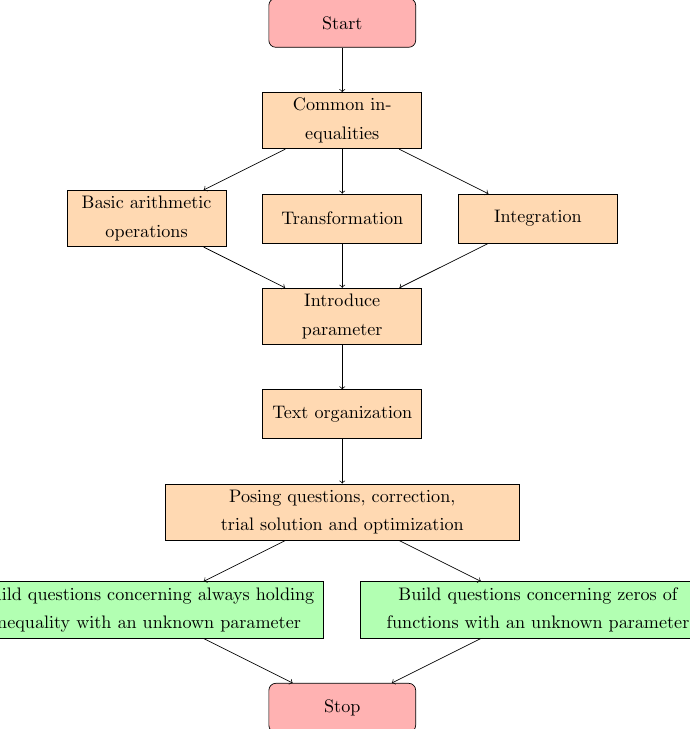
Figure 2. The design framework of math exam questions of always holding inequalities and zeros of functions with an unknown parameter for the